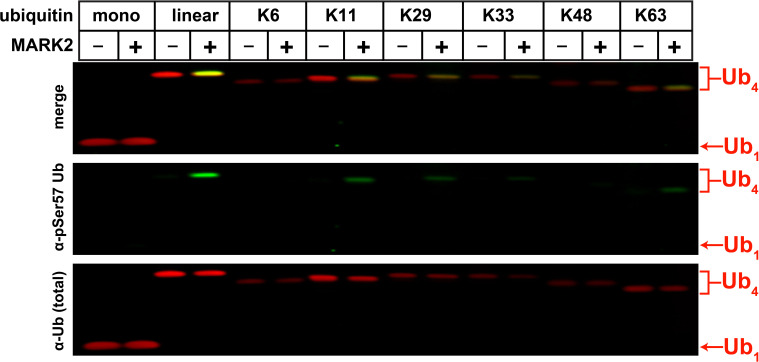
Determination of MARK2 substrate preference by analyzing activity toward tetra-ubiquitin chains with different linkages.Ubiquitin phosphorylation at the Ser57 residue was determined by Western blot using an anti-phospho-Ser57 ubiquitin antibody.